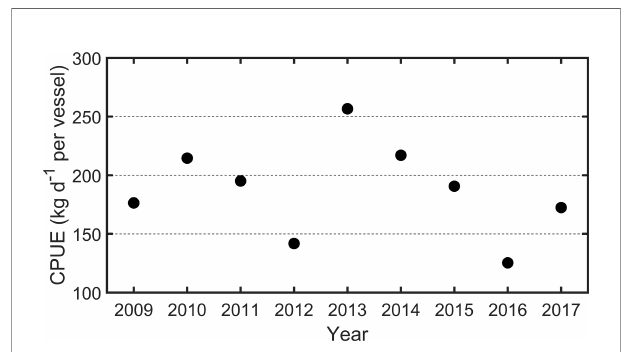
FIGURE 4 | Annual CPUE of swordtip squid ( Uroteuthis edulis ) from 2009